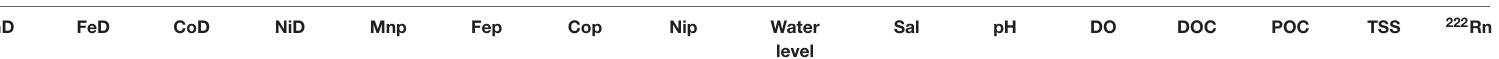
TABLE 4 | Matrix of Pearson correlation coefficients between trace metal concentrations and different physicochemical parameters in the tidal creek during the wet season. (a) Neap tide: